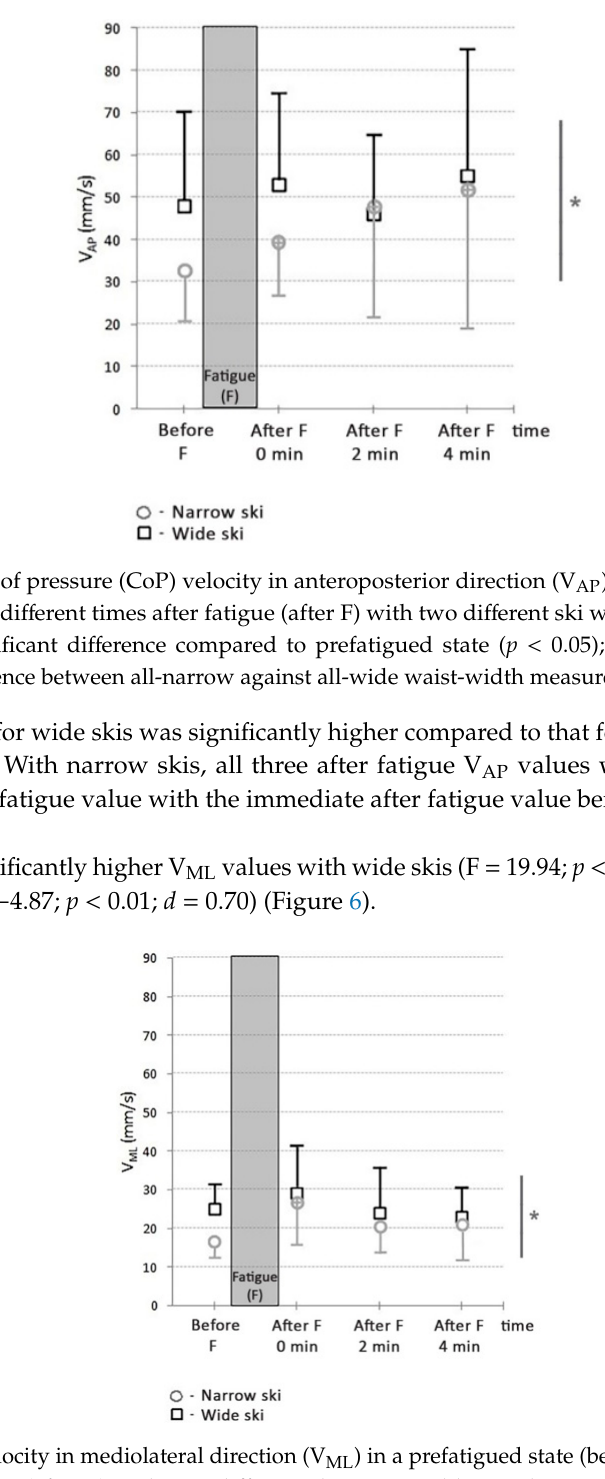
Figure 6. CoP velocity in mediolateral direction (V ML ) in a prefatigued state (before F) and at different times after fatigue (after F) with two different ski waist-widths. + depicts statistically significant difference compared to prefatigued state ( p < 0.05); * depicts statistically significant difference between all-narrow against all-wide waist-width measurements.